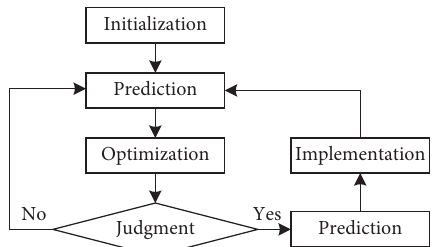
Figure 5: Flow chart of the fan active frequency control strategy for MPC.